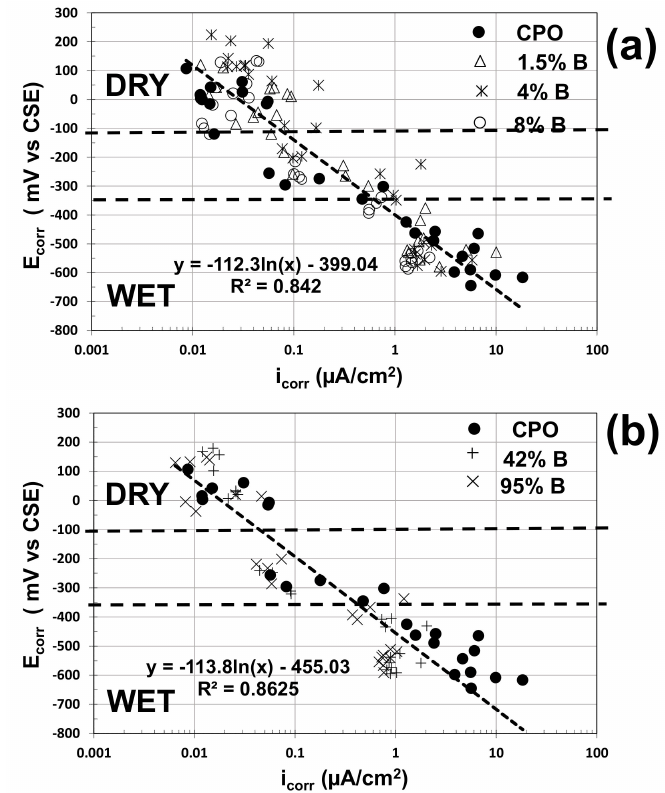
Figure 8. Composite plots between the electrochemical parameters E corr and i corr for: ( a ) control vs. low OFI mucilage concentration; ( b ) control vs. high OFI mucilage